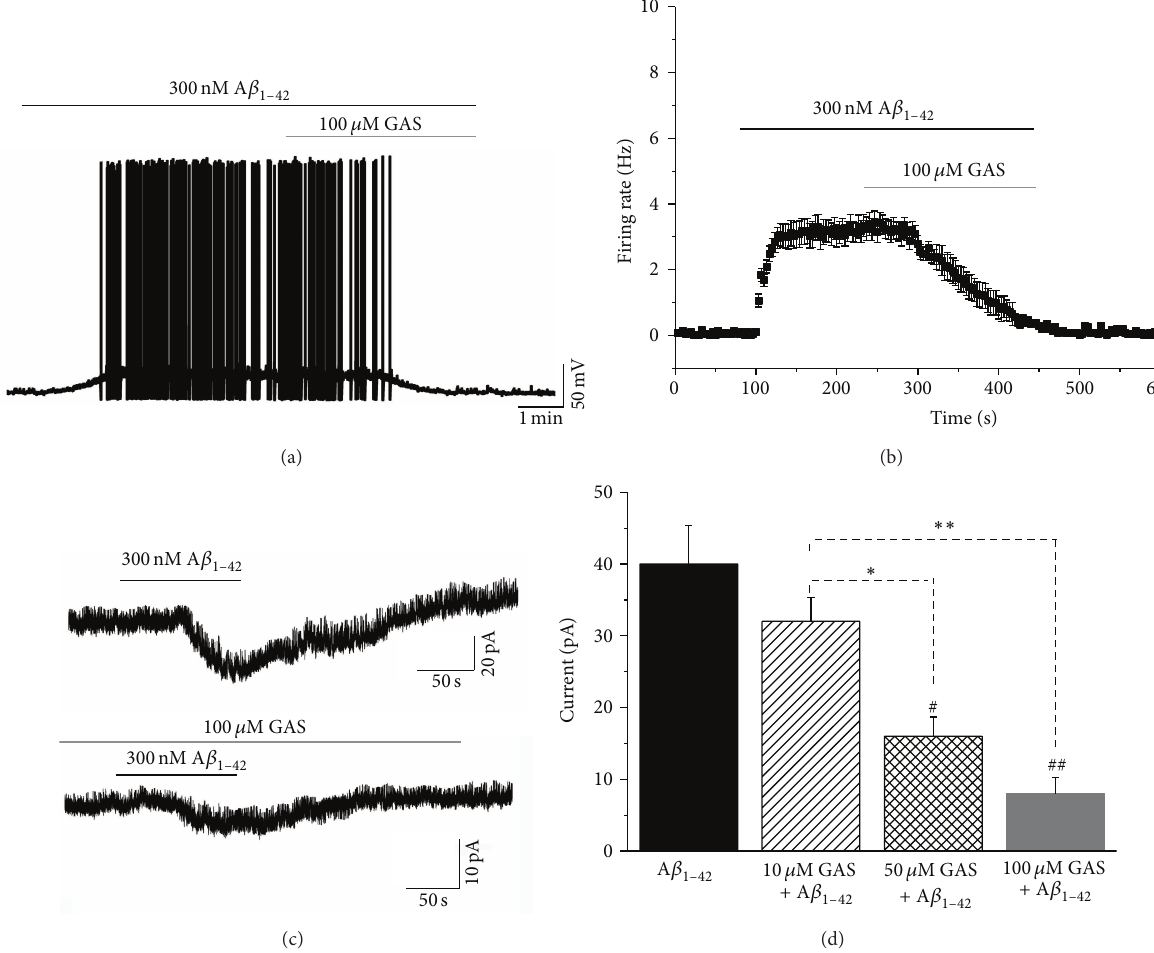
Figure 6: Inhibitory effects of GAS on A 𝛽 1 significantly inhibited in the presence of GAS. (b) Group data of 8 tested EC neurons showing the A 𝛽 1 calculated at 5s intervals. (c) 300 nM A 𝛽 1 (d) Group data of 6 tested EC neurons. The pretreatment of GAS decreased A 𝛽 1 ( # 𝑃 < 0.05 , ## 𝑃 < 0.01 versus A 𝛽 1